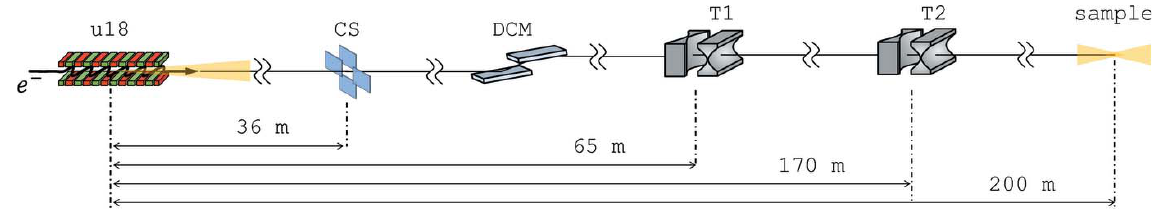
Figure 2 Schematic view of the beamline with the distances used in the simulations. The source is the undulator u18 set to K = 1.851 (7 keVat first harmonic). CS is the coherence slit that controls the coherent fraction. DCM is the double-crystal monochromator (not used in the calculations). T1 and T2 are the two transfocators, idealized in single parabolic lenses. The observation plane (sample) is 200 m from the source. Table 1 Configurations selected for 2D